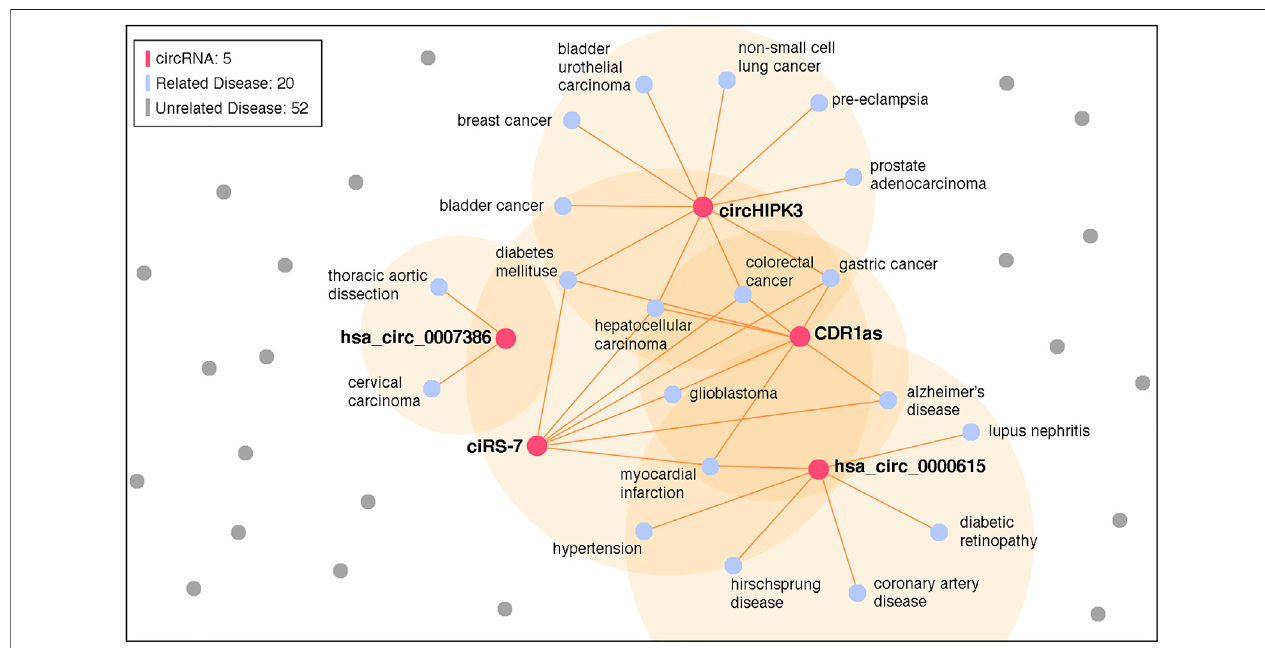
FIGURE 7 | Knowledge graph of the selected circRNA associations. A total of 5 circRNA and 20 related diseases is identi fi ed in the